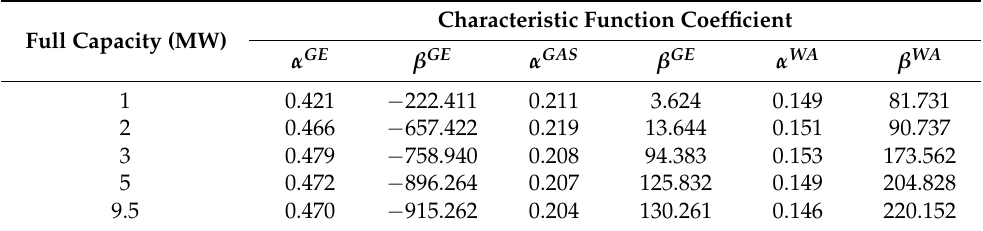
Table 2. Performance parameter of the CCHP.